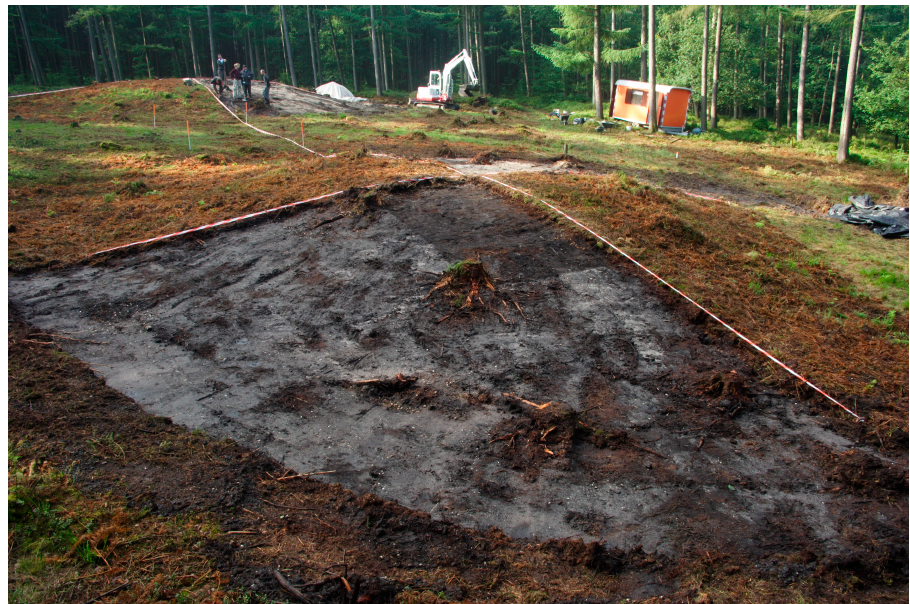
Figure 3. Recent barrow excavation at Apeldoorn – Echoput (Source: Reference [64]).